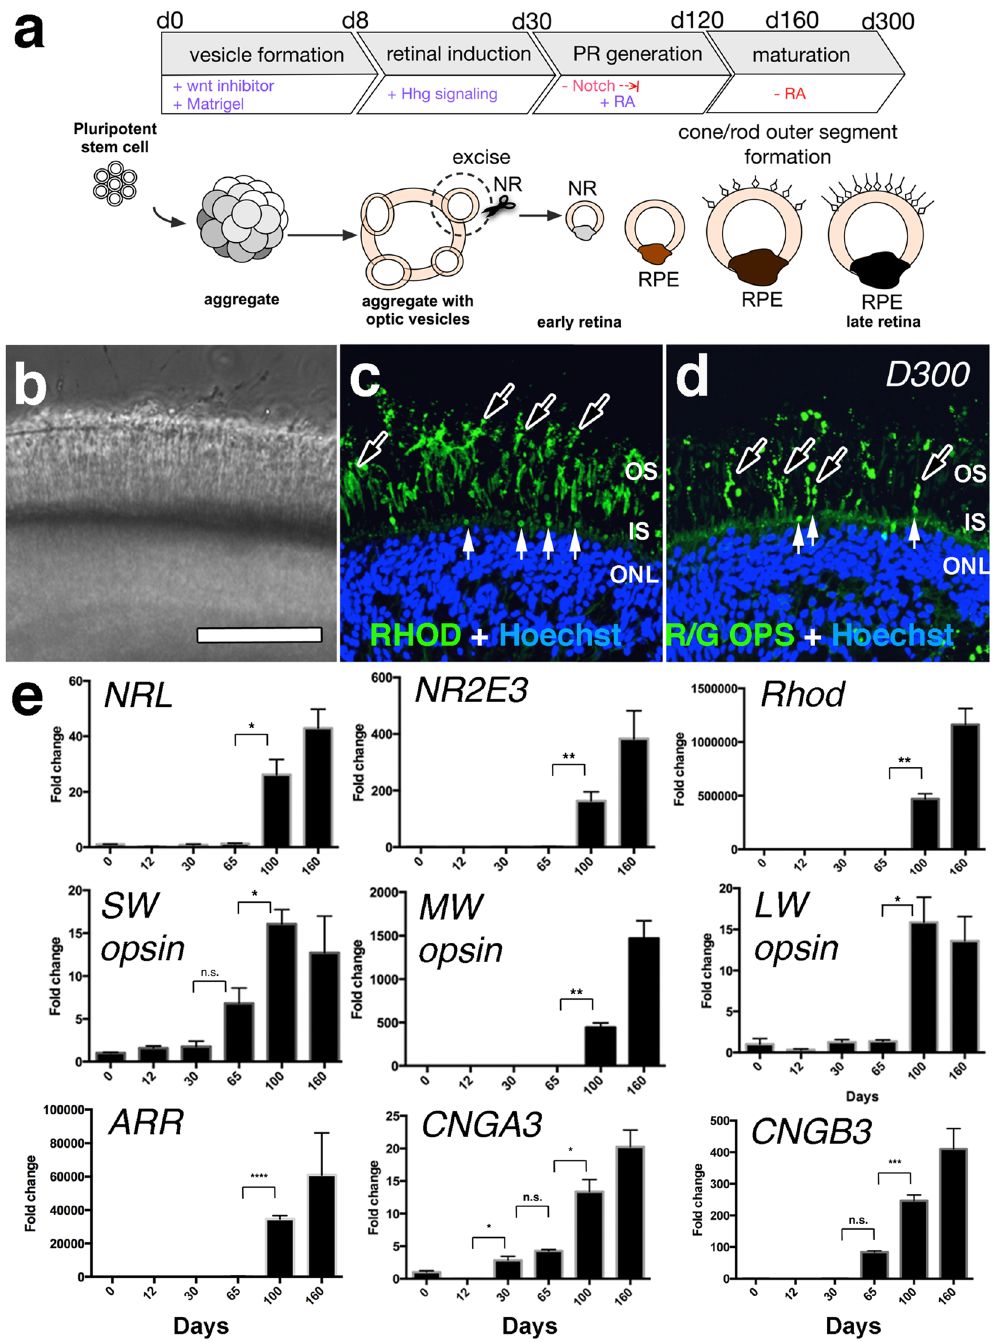
Figure 5. Localization of cone and rod opsins is restricted to outer segments late in Day 300 retina cups derived from IMR90.4 iPSCs. ( a ) Schematic diagram of the important stages during the transition from pluripotent stem cells into 3D retina cups bearing rod and cone outer segments. ( b ) A brightfield image of exuberant POS growth from the surface of RCs. The distal tips of POS are prominently labeled with antibodies against ( c ) rhodopsin and ( d ) red-green opsin. Black arrows indicate outer segment-like structures while white arrows indicate inner segment structures. ( e ) Quantitative analysis of select photoreceptor genes (NRL, NR2E3, Rhod, SW-, MW- and LW-opsin, arrestin and the calcium channel proteins CNGA3, and CNGB3) was carried out to show quantifiable changes in gene expression. Target genes were normalized against the geometric means of the reference housekeeping genes CREBBP, FBXL12, and SRP72. Data reflects the expression levels from pooled samples (n = 10 per time point) from three replicates per time point and error bars represented as s.e.m. The difference between the indicated time points is statistically significant by Student’s t-test where **** P < 0.0001, *** P < 0.001, ** P < 0.01, * P < 0.05; ns, not significant. POS = photoreceptor outer segment; PR = photoreceptors; RC = retina cup. Scale bars = 50 μ